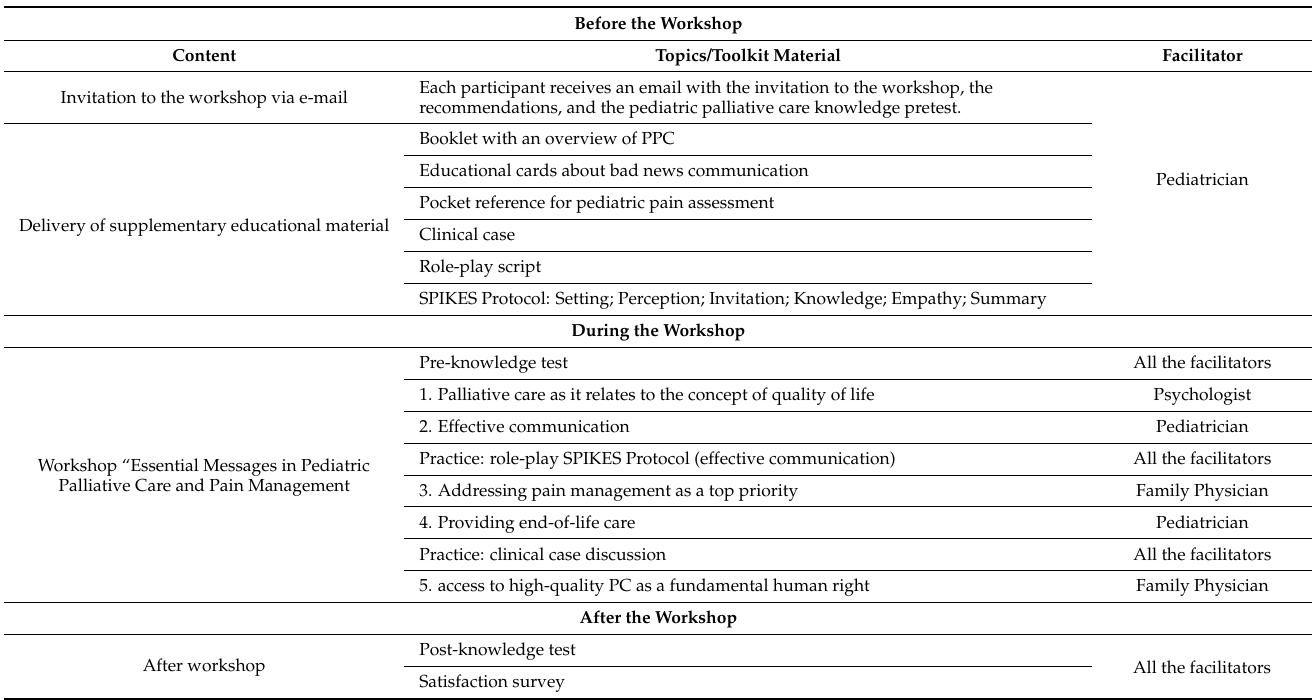
Table A1. Description of the development of EmPalPed educational toolkit